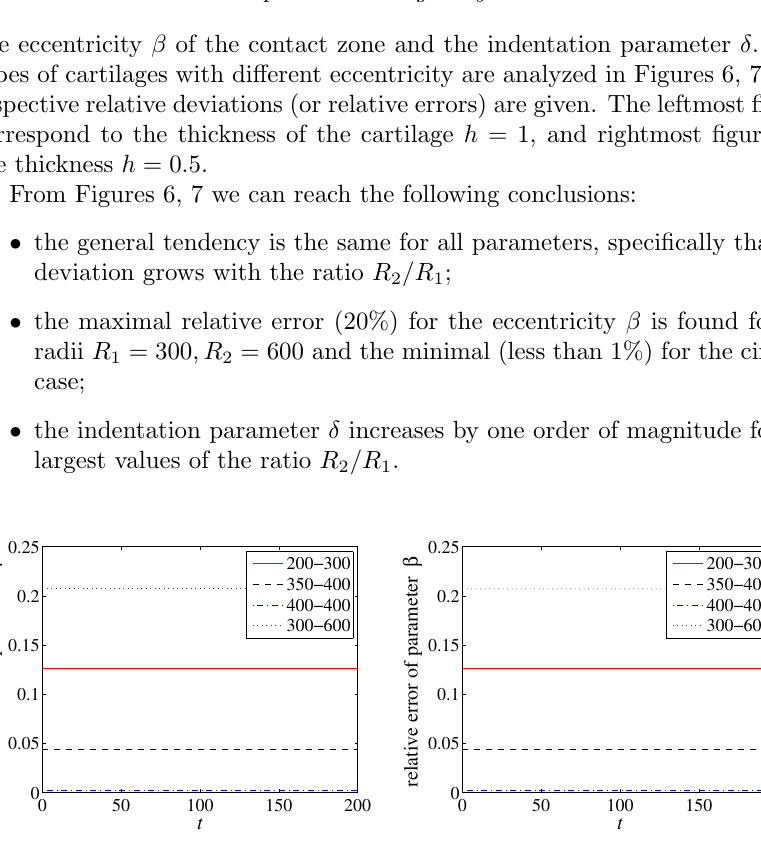
Figure 6. Relative error for the parameter β . The base of comparison is our approximate solution; left - for h = 1, right - for h = 0 . 5.